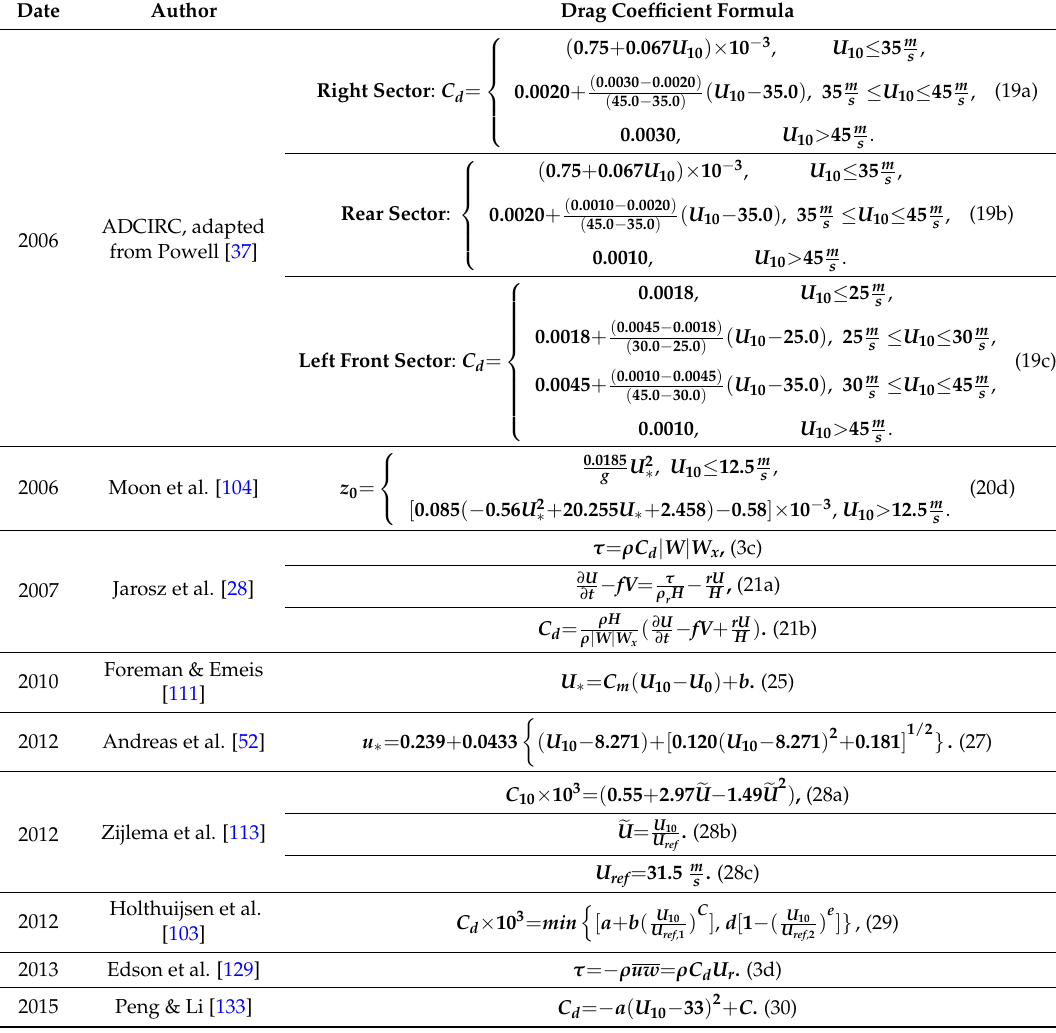
Table 2. Drag Coefficient Formulations following the Development of GPS Sondes